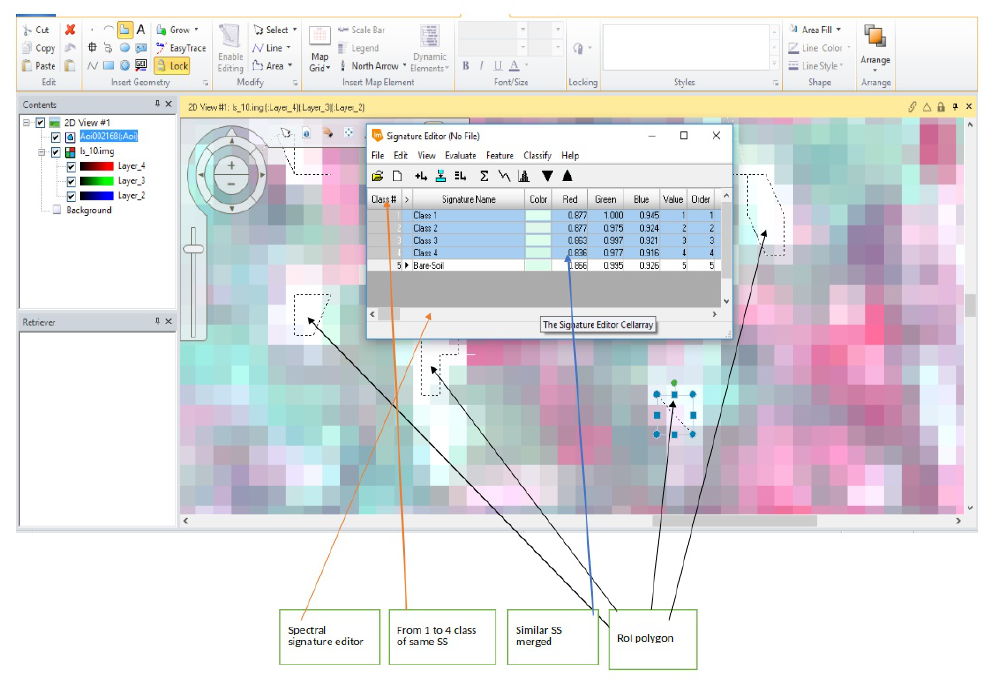
Figure 6. Semi-Automatic feature extraction using